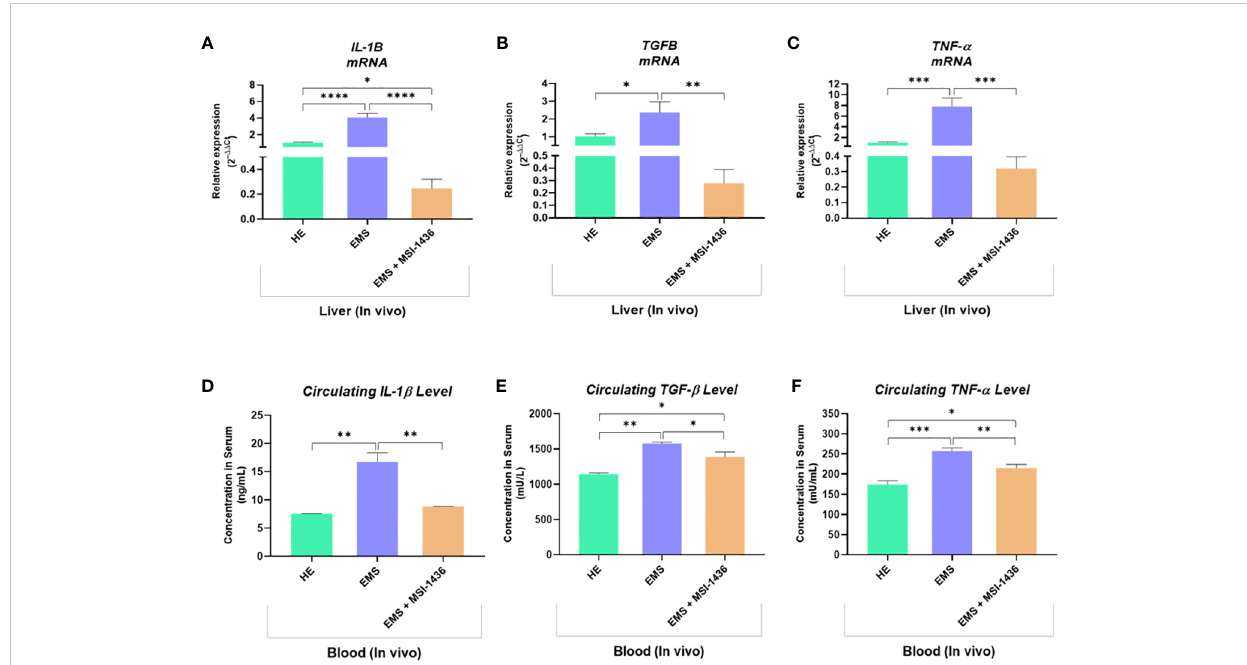
FIGURE 12 In fl ammatory mediators status changes resulting from the in vivo MSI-1436 administration to EMS affected horses. Relative gene expression of IL-1 b (A) , TGF- b (B) and TNF- a (C) determined by means of RT-qPCR technique in liver biopsies sampled following 4 weeks of MSI-1436 treatment. Circulating levels of IL-1 b (D) , TGF- b (E) and TNF- a (F) proteins quanti fi ed using speci fi c ELISA assays in blood samples derived from each experimental group. Data are presented as a mean value obtained from measurments ± SD. Statistical signi fi cance was marked as follows: *p-value < 0.05; **p < 0.01; ***p-value < 0.001 and ****p-value <